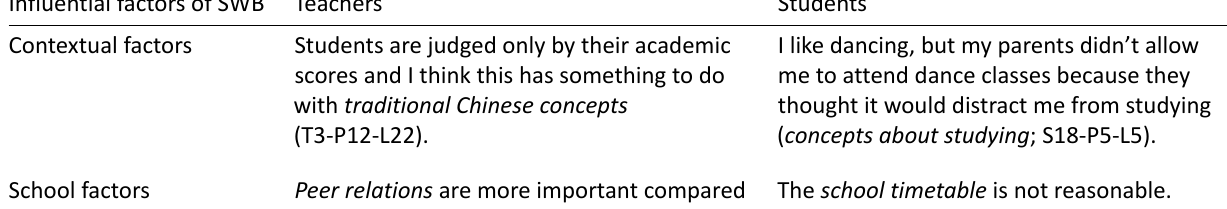
Table 2. Excerpts from the interviews about student SWB and its influential factors. Influential factors of